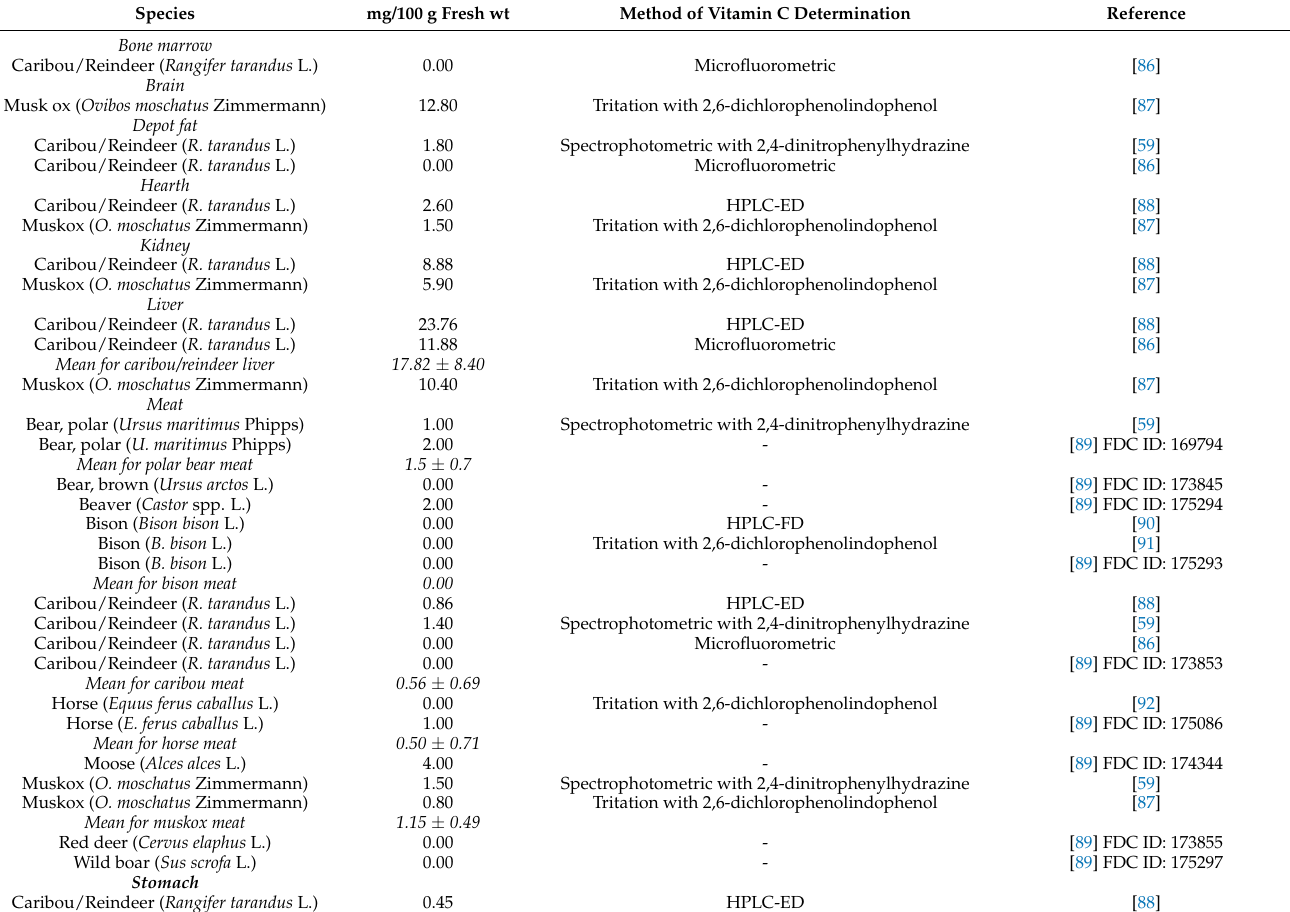
for M3H populations [83,84], and weighting food amounts for the different age groups Supporting Table S7. Table 1. Ascorbic acid contents of the main organs of grass-fed mammals usually consumed by Paleolithic hominins.